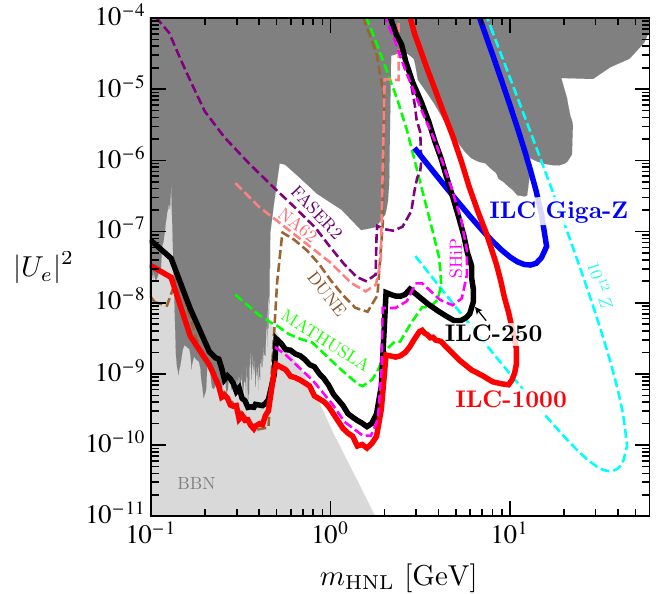
Figure 5 . Sensitivity reach of ILC beam dump experiment to HNLs mixing with the electron neutrino in the mass and mixing plane, assuming 10 year run at ILC-250 (black solid) and ILC- 1000 (red solid). The number signal events more than 5.5 (9.1) is required at ILC-250(1000), which corresponds to the 95% C.L. sensitivity. The discussion about the background is in section 4.1. The current exclusion bounds are shown in the gray region, see section 4.3. The darker grey region is from the laboratory bounds, and the lighter gray region is the BBN bound for the HNL, which is roughly τ 0 . 02 s [30]. Sensitivity reach through 10 9 Z -decays at ILC is shown as a blue HNL > solid line. See section 4.2. For a comparison, dashed lines show a sensitivity reach of the DUNE experiment [40] (brown), the FASER2 experiment [41] (purple), the NA62 experiment [1] (orange), and the SHiP experiment [8] (magenta), the MATHUSLA experiment [42] (green), and 10 12 Z - decays that could be realized at the FCC-ee experiment